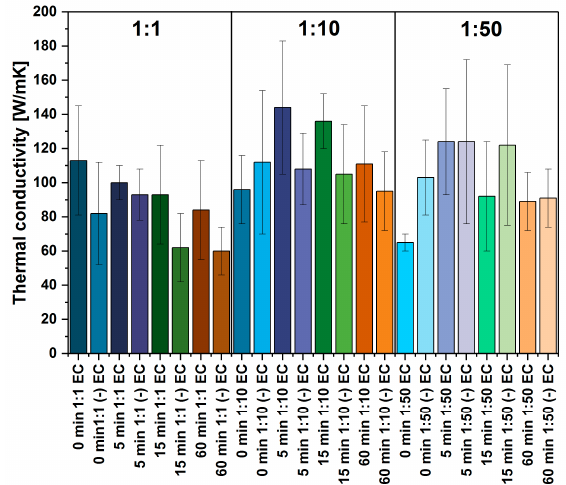
Figure 8. The influence of grinding time and EC content on thermal conductivity (before and after EC removal indicated with (-) prefix).